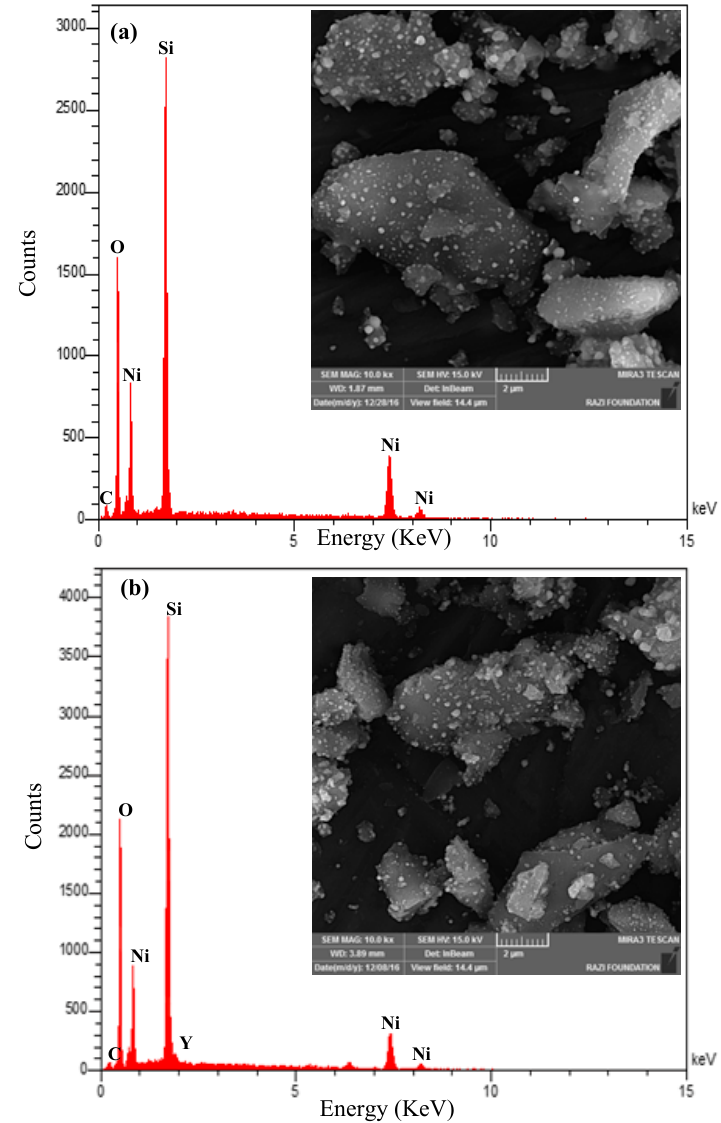
Figure 12. EDX and FESEM analysis of used ( a ) 25Ni/SBA-16 and ( b ) 25Ni-2.5Y/SBA-16 oxygen carriers.